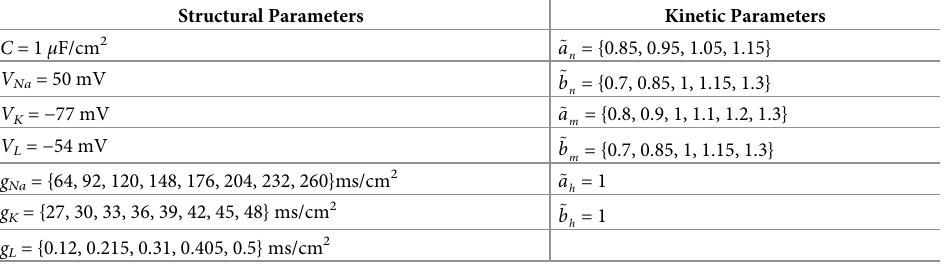
Table 1. Parameters varied in the Hodgkin-Huxley simulations according to the designed factorial experiment design. Structural Parameters Kinetic